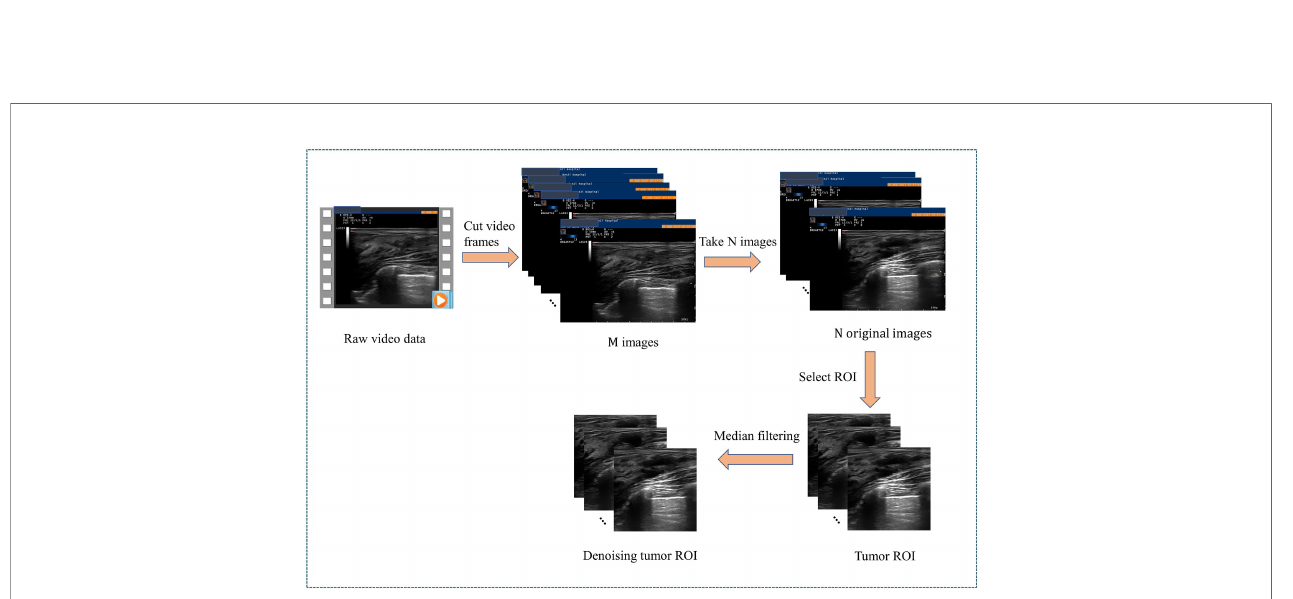
FIGURE 3 | Data preprocessing of an ultrasonic video. ROI, Region Of Interest.